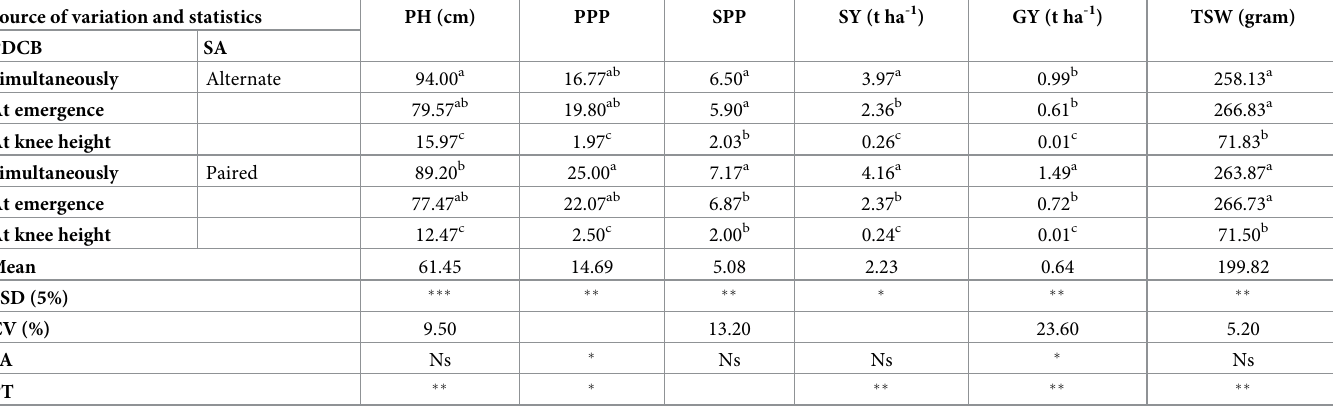
Table 3. Response of common bean yield attribute and yield to its planting time and spatial arrangement in maize -common bean intercrops at Adet research sta- tion, Northwestern Ethiopia a . Source of variation and statistics